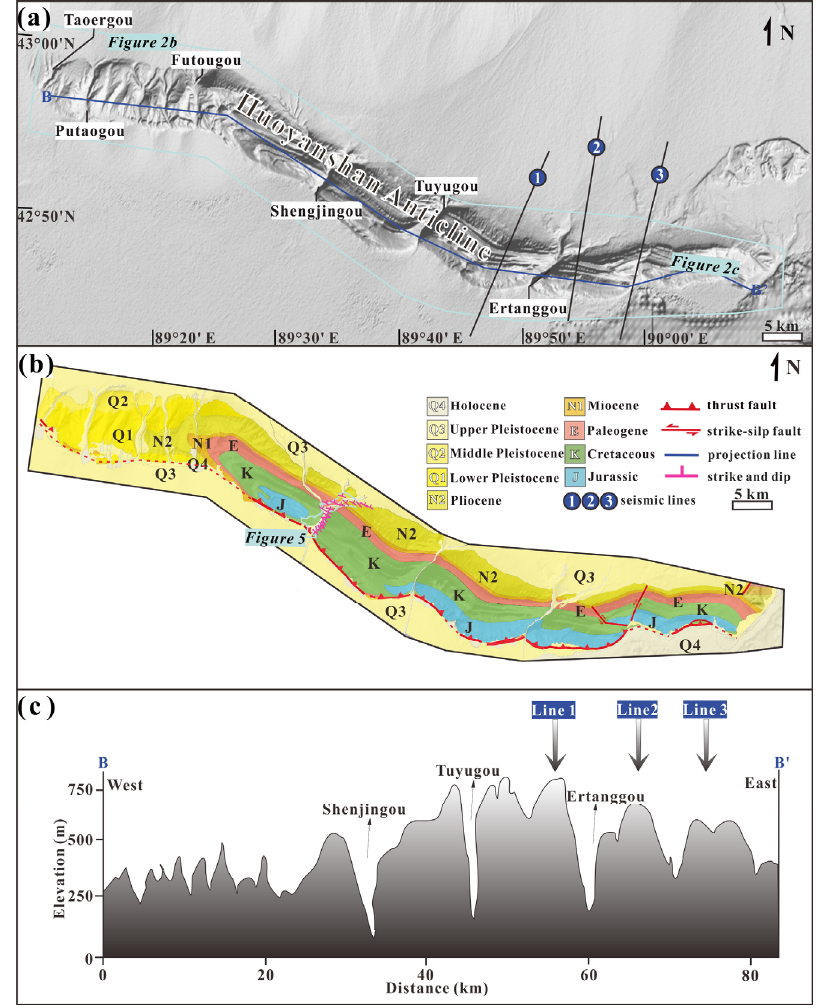
Figure 2. ( a ) Topography of the Huoyanshan structure (location in Figure 1c), lines 1–3 are seismic lines. ( b ) Simplified geologic map (modified from Peng) [56], location in ( a ). ( c ) Strike profile of the Huoyanshan anticline (location of B–B ′ in ( b )).